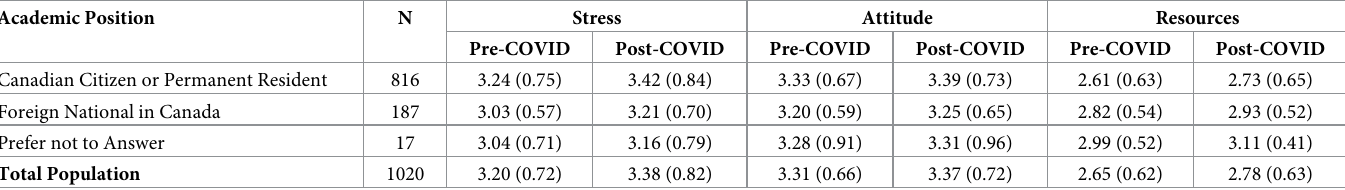
Values represent mean score with standard deviation in